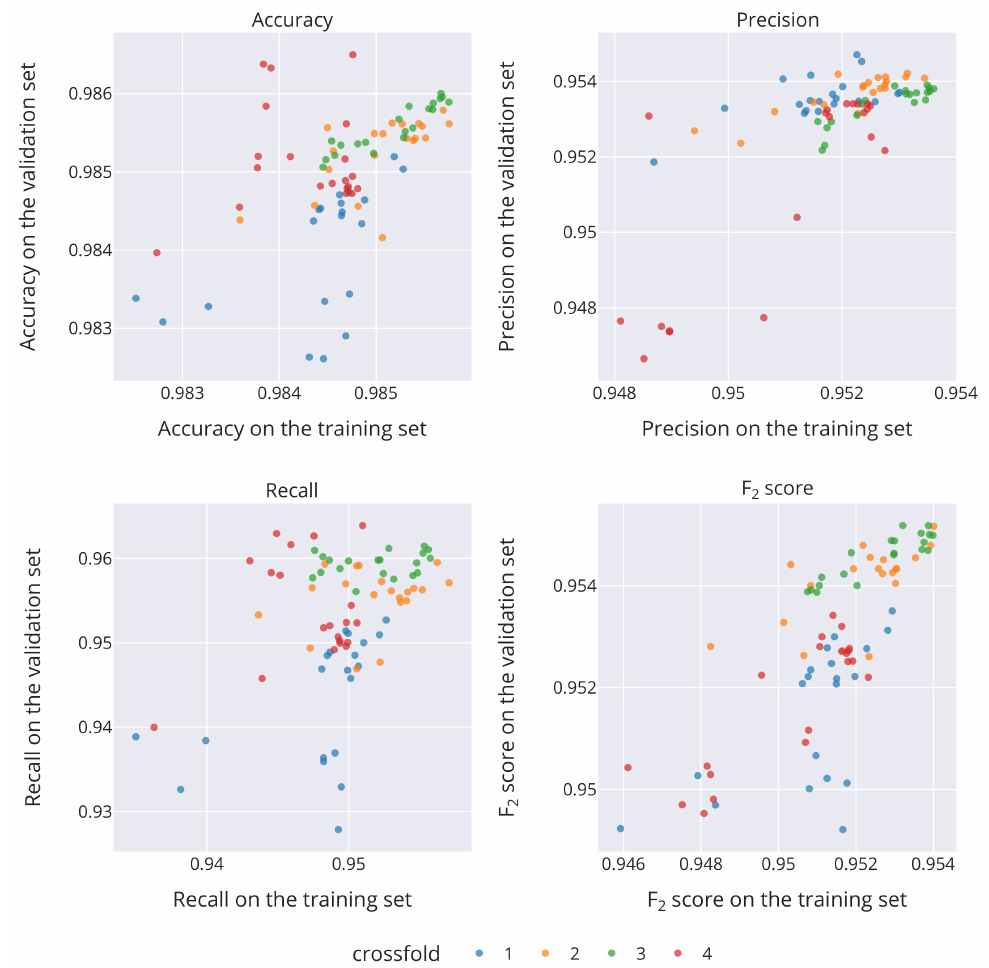
Figure 2. Metrics during the last epoch of training and validation—top 20 results for each